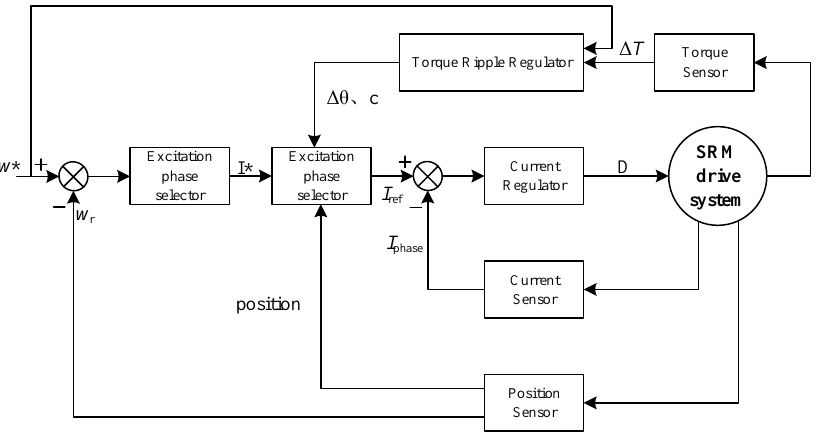
Figure 9. OSRM Speed-current-torque ripple closed-loop system.